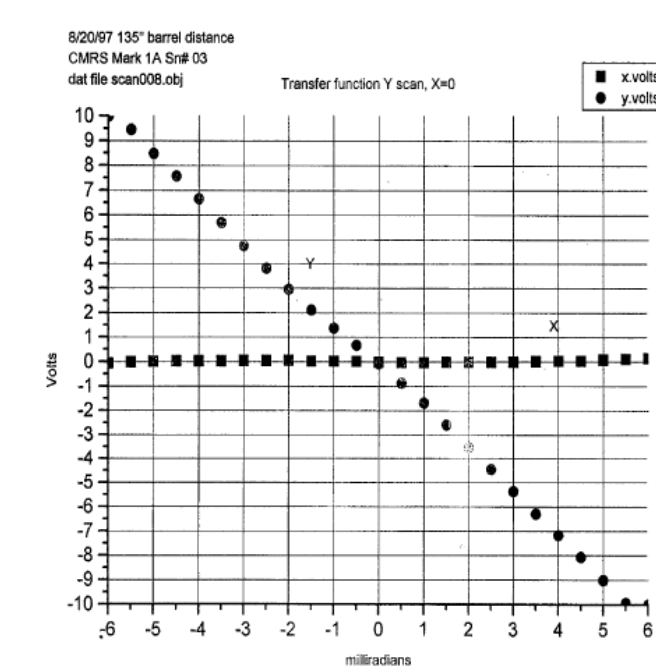
Fig. 1. Schematic diagram of CMRS optics assembly.